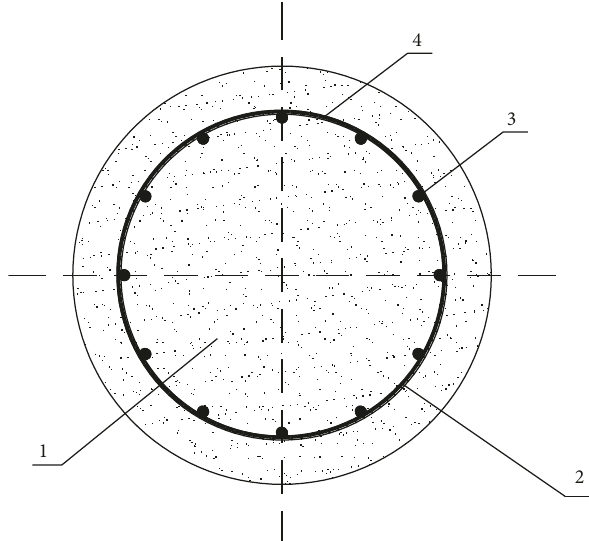
Figure 18: Schematic diagram of the fiber- and steel-reinforced cemented soil column (1: fiber-reinforced cemented soil column; 2: steel cage; 3: main bars; 4: spiral